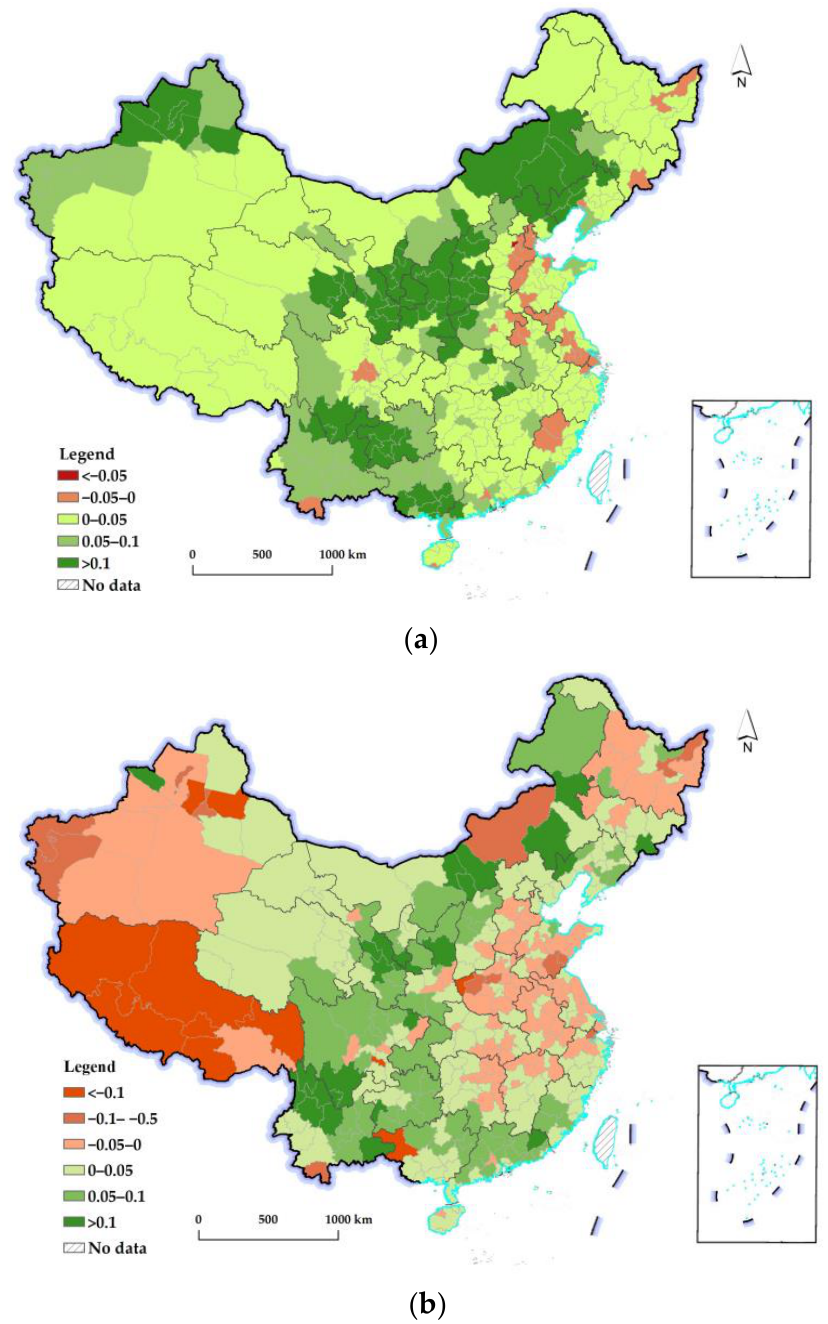
Figure 7. The changes in the REQ from 2000 to 2020. ( a ) 2000 – 2010; ( b ) 2010 – 2020. Figure 8 presents the results of the hot-spot analysis. From 2000 to 2010, the cold spots were mainly concentrated in Shandong, Jiangsu, and Zhejiang in the coastal region and Anhui and Jiangxi in the central region. Hot spots were distributed in the northwestern and southwestern regions. From 2010 to 2020, the cold spots shrank, but they were still concentrated in Shandong and Jiangsu. Anhui, Henan, and Hubei in the central region and Tibet and Xinjiang in the western region experienced an increase in cold spots. In contrast, the hot spots significantly expanded in the western region, indicating that the REQ continuously improved during the research